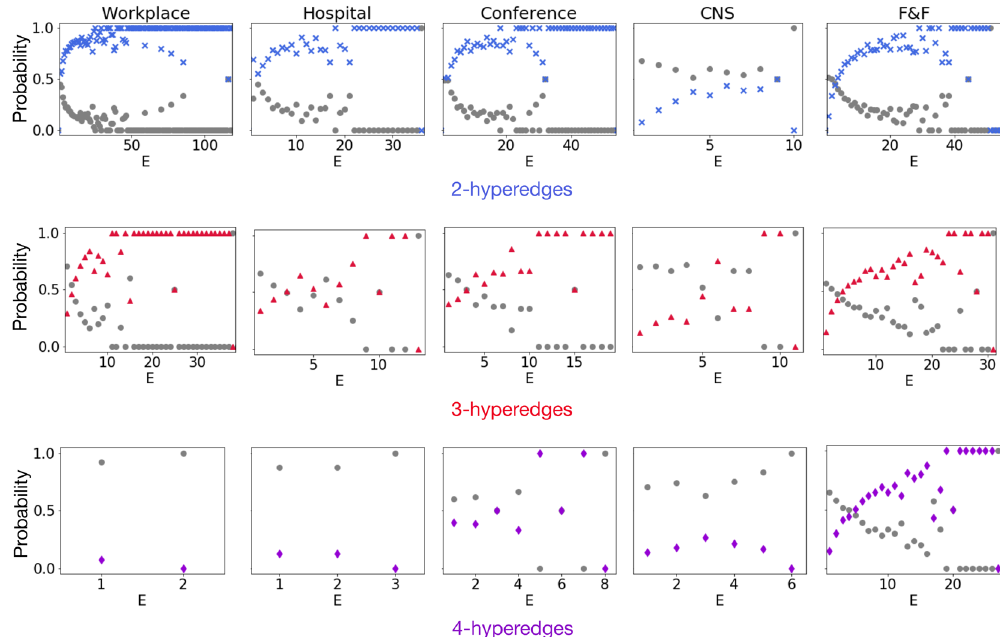
Figure 4. Group evolution and temporal reinforcement of higher-order human interactions. Each panel depicts the probabilities that after a train of interaction at least with E events the people involved either interact again in the same or a higher-order structure (coloured symbols) or they do not reconnect anymore (grey symbols) within (cid:31) t . Panels in the first line show results for dyadic trains; panels in the second line for triadic (3-hyperedge) trains; and panels in the third line for 4-body (4-hyperedge). Results are shown for the three analysed datasets for trains identified with (cid:31) t = 600